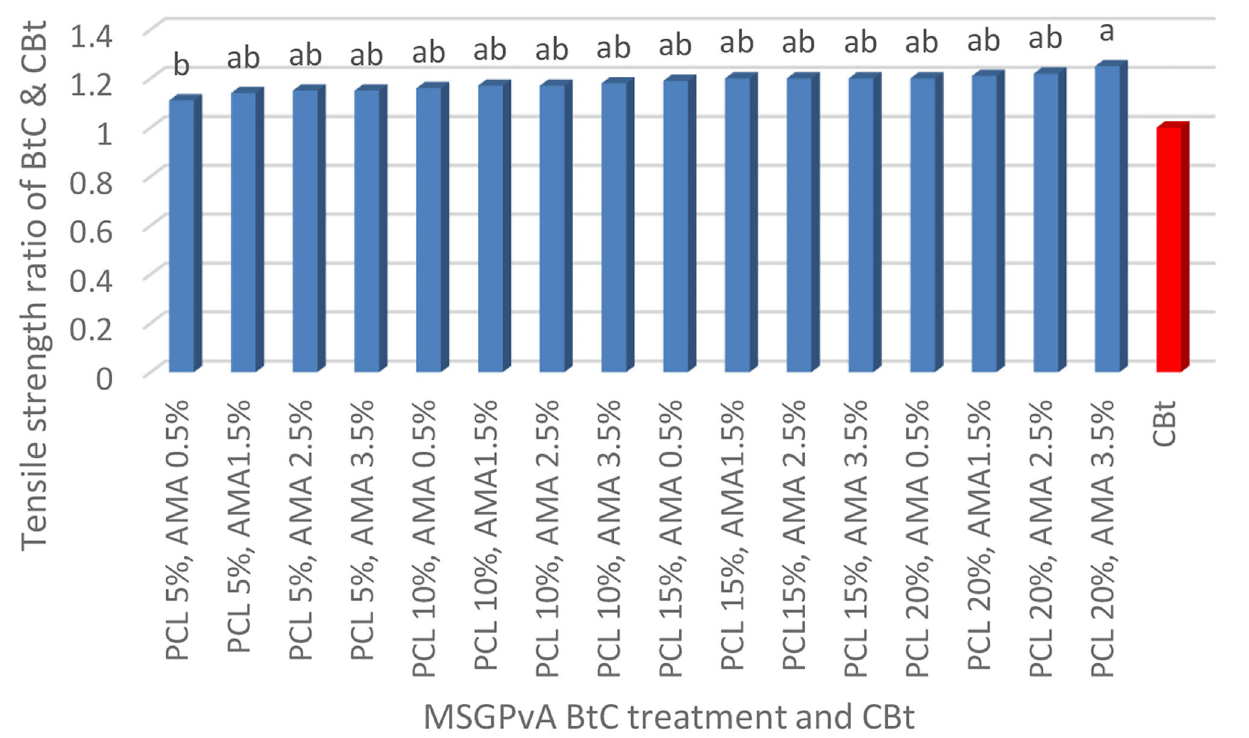
FIGURE 1 | Relationship of MSGPvA BtC and CBt with the tensile strength ratio of BtC to